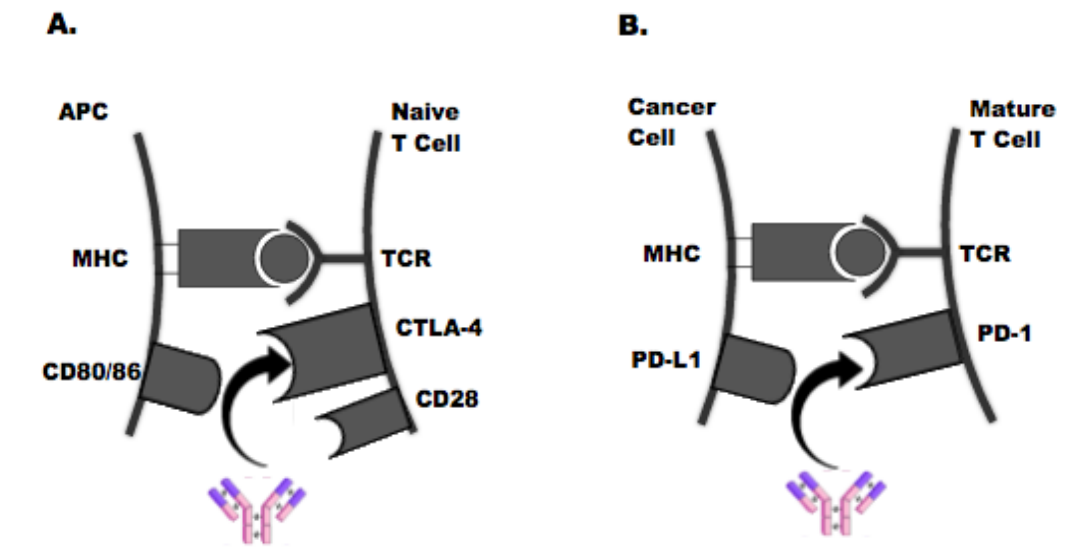
Figure 1. CTLA-4 and PD-1 Pathways. ( A ) This schematic depicts an antigen-presenting cell (APC) modulating early T-cell proliferation in the lymphatic system through CTLA-4 up-regulation. Following recognition and binding of a T-cell receptor (TCR) to a tumor-associated antigen expressed in the major histocompatibility complex (MHC), CTLA-4 outcompetes co-stimulatory receptor CD28 for binding to CD80/86 and dampens T-cell activation and proliferation. Reversal of this process with an antibody directed against CTLA-4 is shown. ( B ) This schematic shows a cancer cell regulating mature T-cell activation in peripheral tissue through PD-1 modulation. PD-1 (which can also be expressed on non-T cell subsets, including myeloid cells) interacts with its ligand PD-L1 on cancer cells or APCs to facilitate immune escape. Reversal of this process with a PD-1 antibody is depicted.